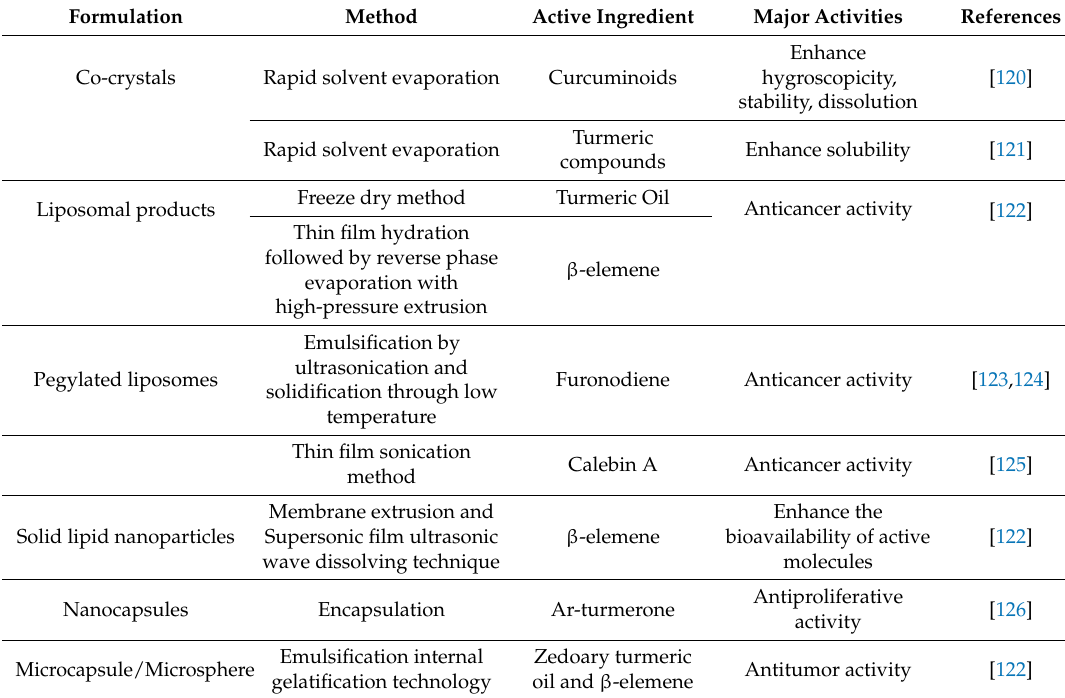
Figure 4. Various encapsulation techniques for non-curcuminoids in different drug delivery formulations. Table 3. Various formulations of non-curcuminoids and their biological activities.